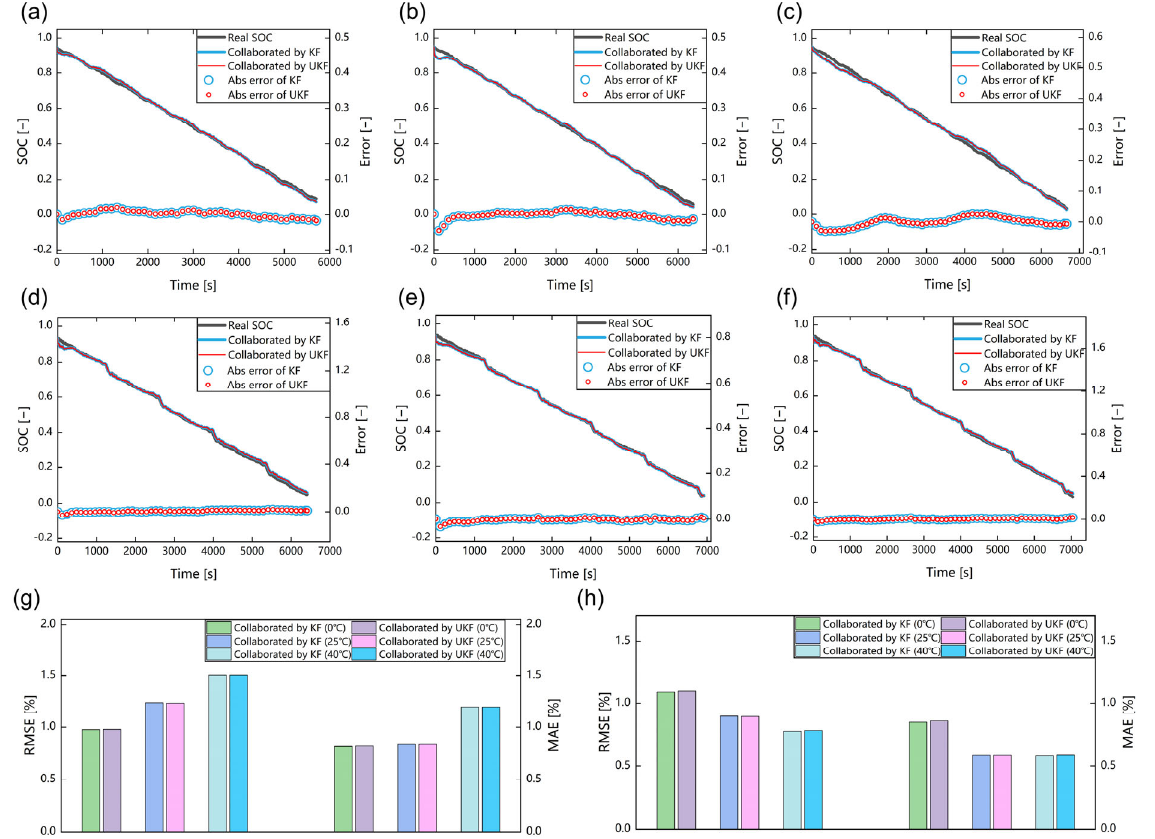
Figure 6. SOC estimation results with end ‐ cloud collaboration system under different temperatures: ( a – c ) donate the estimation results for US06 driving cycle under 0 °C, 25 °C and 40 °C, respectively; ( d – f ) donate the estimation results for FUDS driving cycle under 0 °C, 25 °C and 40 °C, respectively; ( g , h ) donate the RMSE and MAE analysis for US06 driving cycle and FUDS driving cycle, respectively. Table 2. RMSEs and MAEs of SOC estimation results with CNN ‐ LSTM and end ‐ cloud collaboration system under different temperatures.